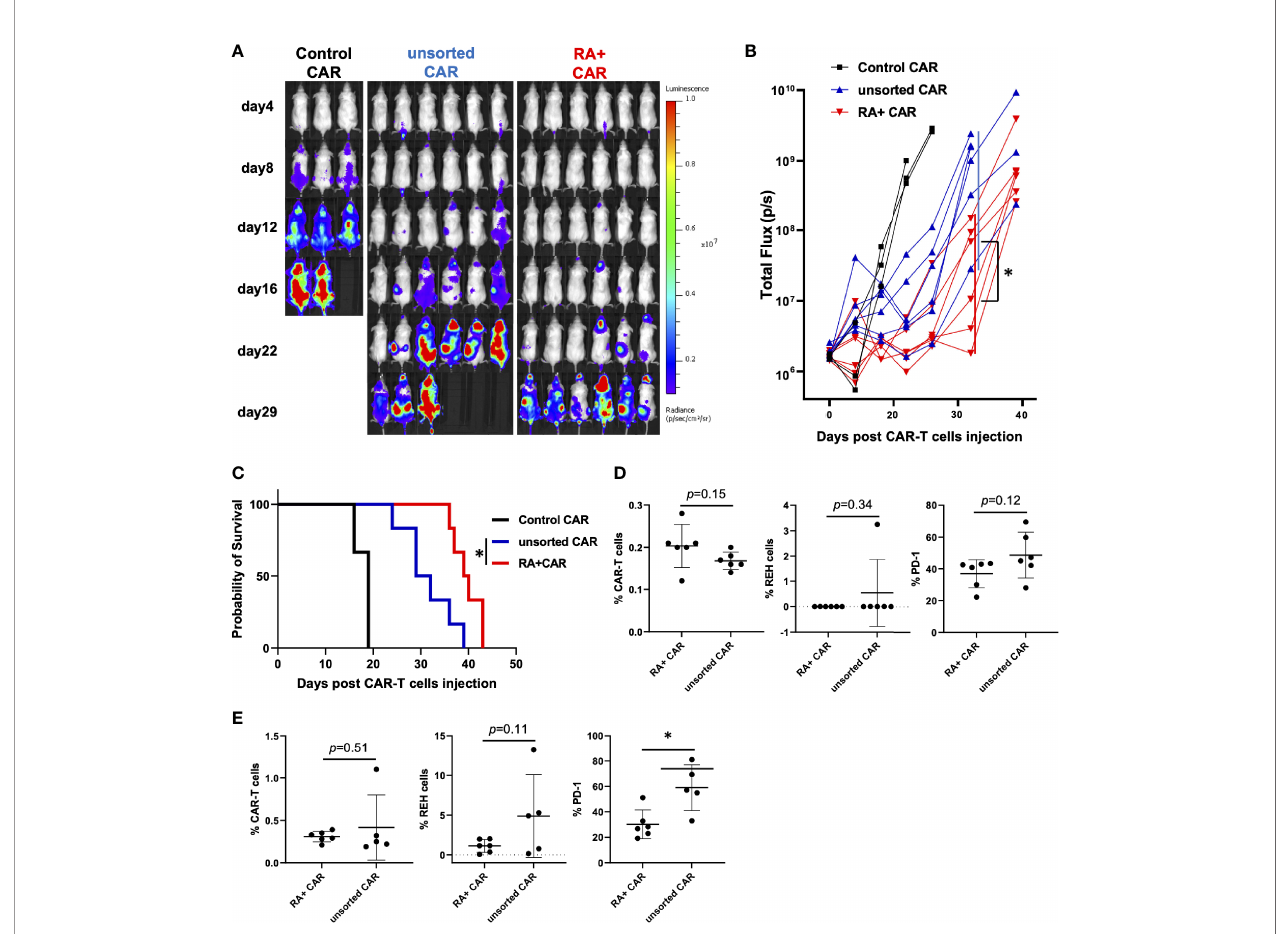
FIGURE 4 | CD45RA + chimeric antigen receptor (CAR)-T cells achieved prolonged tumor control than unsorted CAR-T cells in vivo stress test. We infused 1 × 10 6 REH-FFLuc cells into NSG mice via the tail vein. Six days later, 1 × 10 5 RA + CAR-T (n = 6), unsorted CAR-T (n = 6), or control (EPHB4) CAR-T (n = 3) positive cells were infused into the tail vein of each mouse. (A) Bioluminescence images of groups of NSG mice after intravenous CAR-T cell infusion. (B) The tumor volumes of each mouse measured as total fl ux (p/s) are shown. The CD45RA + CAR-T group showed a statistically signi fi cant tumor reduction, measured as the mean total fl ux at day 22, compared with the unsorted CAR-T group. (C) The Kaplan – Meier plot of overall survival. The CD45RA + CAR-T group achieved prolonged tumor control compared with the unsorted CAR-T group. Log-rank test: *P < 0.05. (D) On day 15 after CAR-T cell injection, bone marrow analysis showed CAR-T cells (left), REH cells (middle), and PD-1 expression on CAR-T cells (right) by fl ow cytometry. (E) On day 25 after CAR-T cell injection, bone marrow analysis showed CAR-T cells (left), REH cells (middle), and PD-1 expression on CAR-T cells (right) by fl ow cytometry. All data are presented as mean ± standard deviation. *P <